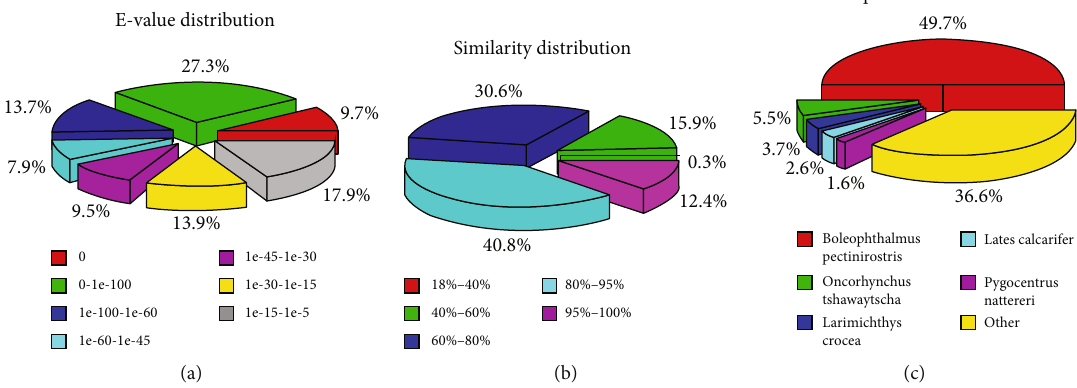
Figure 5: Similarity analysis of unigenes in Synechogobius hasta based on Nr database. Classi fi cation analysis of unigenes against the Nr database for E value distribution (a), similarity distribution (b), and species distribution (c). All unigenes from S. hasta were analyzed using the online BLASTx program with an E value ≤ 10 -5 .